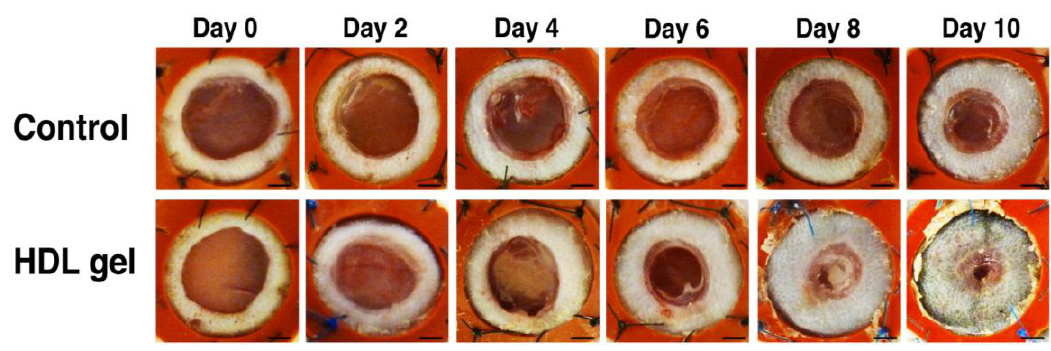
Figure 4. Representative images of the time course of wound healing in C57BL/6 apo E −/− control mice and in C57BL/6 apo E −/− mice treated with topical